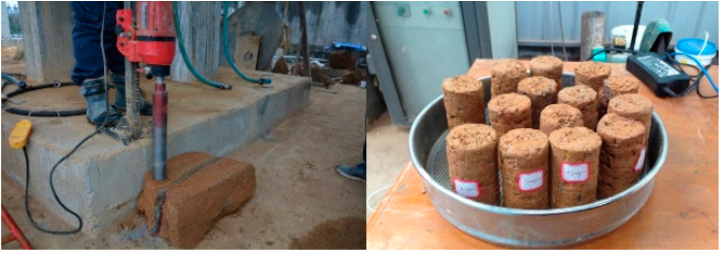
Figure 14. Cross section sampling.